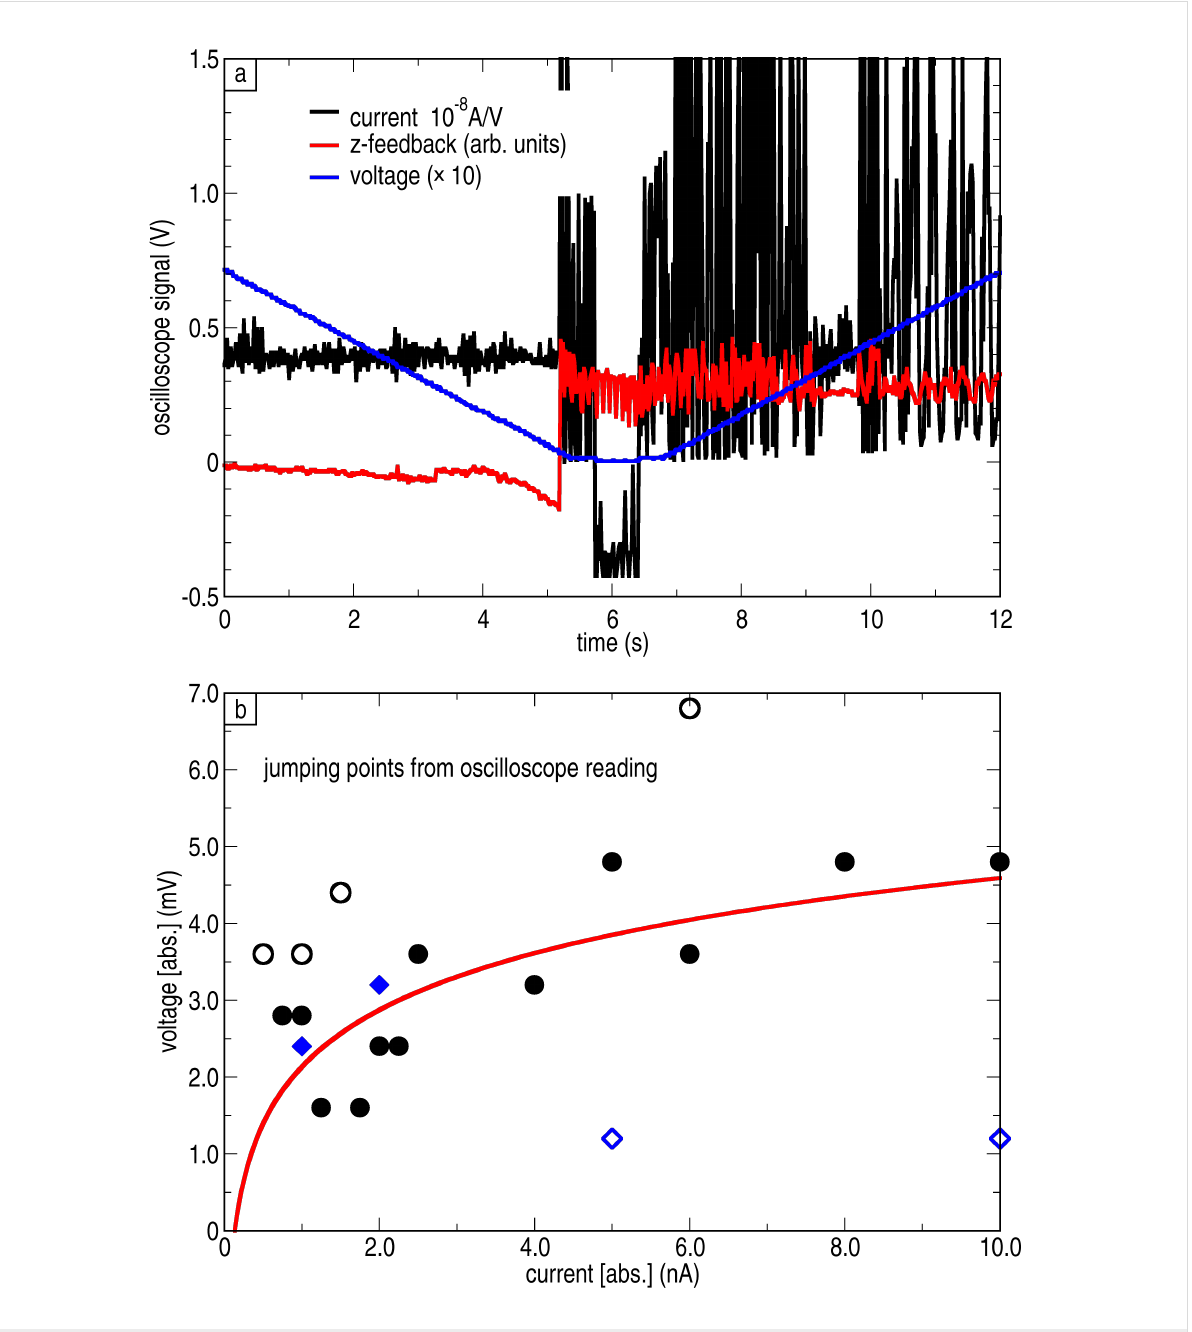
Figure 8: (a) Typical records of the current, bias and z -feedback signals for a successful pick-up. The jumping voltage is read out at the point where the first instability in the current or z -feedback signal is observed. (b) Pick-up voltage for different current setpoints. Bias ramp was started at +1 V (circles) or − 1 V (diamonds). The data of the filled symbols were used for fitting the exponential curve (solid line).